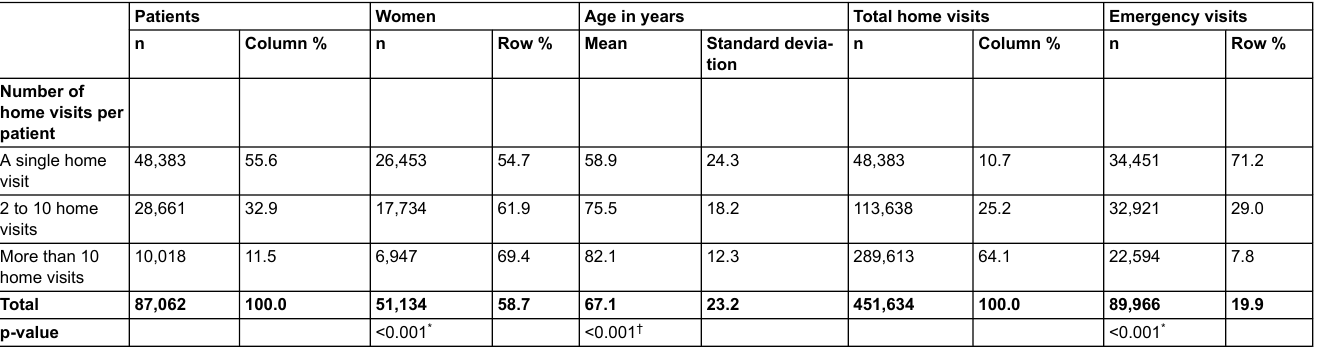
Table 1: Number and proportion of patients, sex/gender, age, total number of home visits and number of emergency home visits, by category of number of visits per patient. Patients